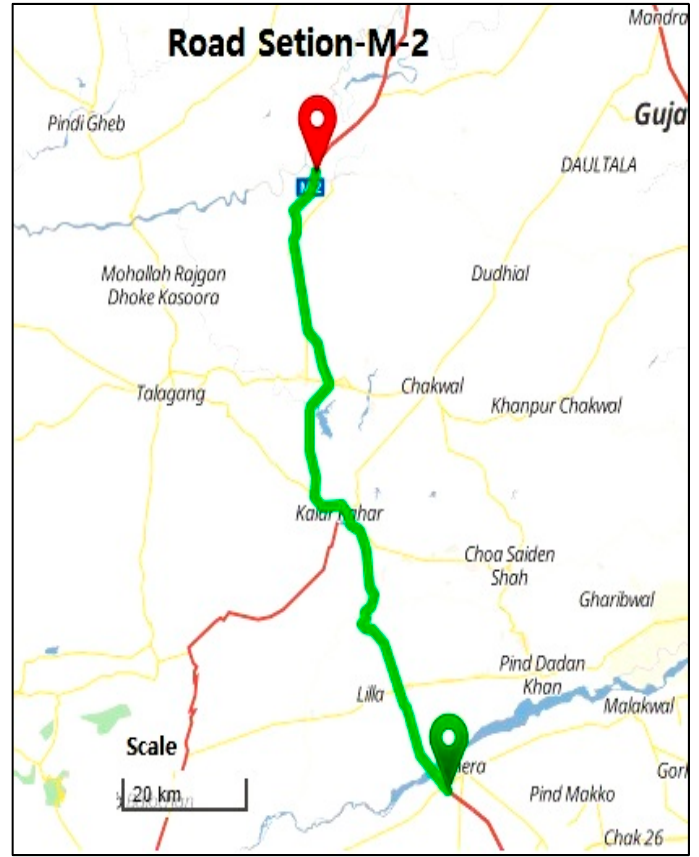
Figure 5. Study area—motorway (M-2) 200–300 km section.